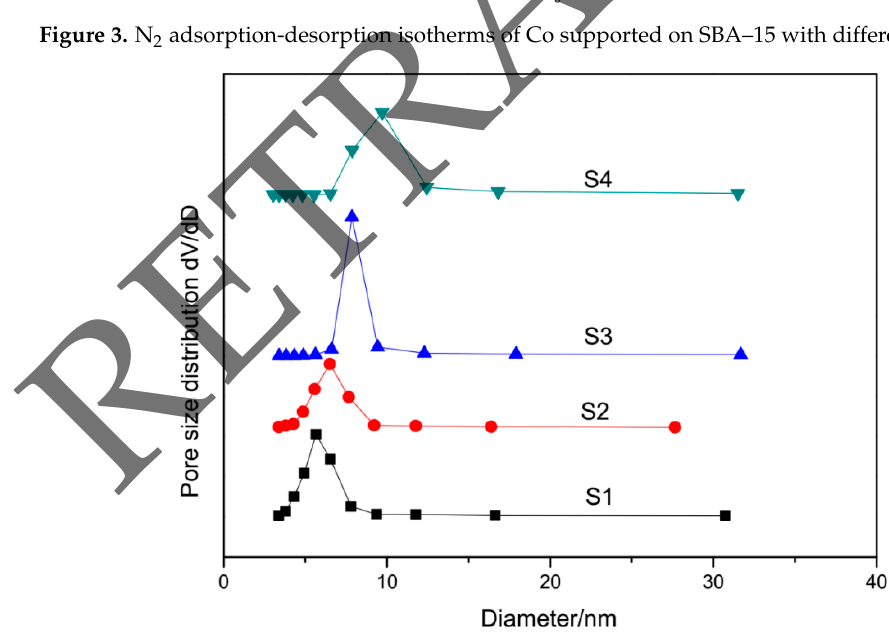
Figure 4. Pore size distribution of the catalysts.